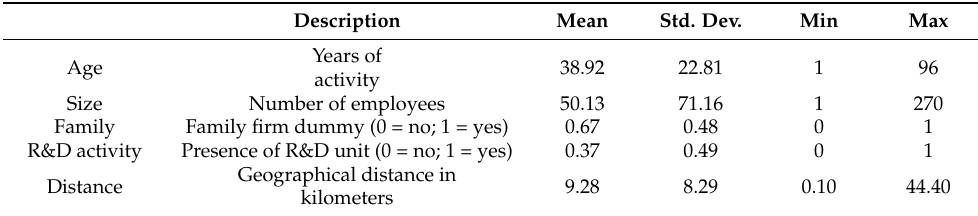
Table 2. Descriptive statistics.